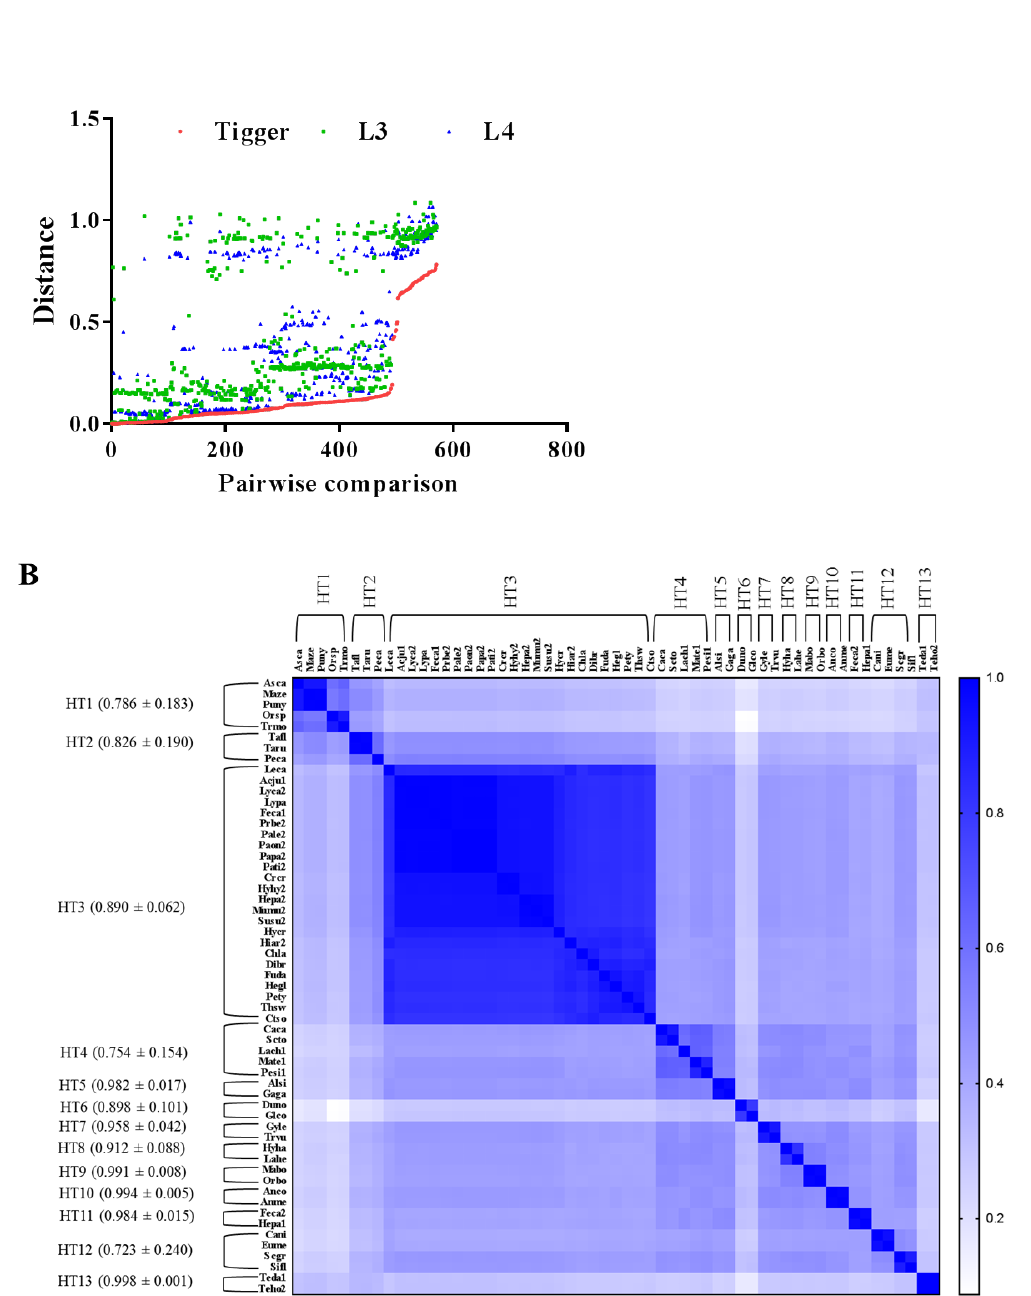
Figure 6. ( A ) Pairwise distance comparisons of Tigger transposons. The graph illustrates the pairwise distances of Tiggers and two organelle ribosomal proteins (L3 and L4) between the species included in this study, the red color represents Tigger transposon, the green color represents RPL3, and the blue color represents RPL4. The distances were obtained from all possible pairwise comparisons (N L3 = 572, N L4 = 572, labeled on the x -axis); ( B ) HT events measured among species contained Tigger elements. Sequence identities between Tigger elements among species. The sequence identities were measured via pairwise comparisons of Tigger CDS sequences (for species abbreviations, refer to Supplementary Table S1).